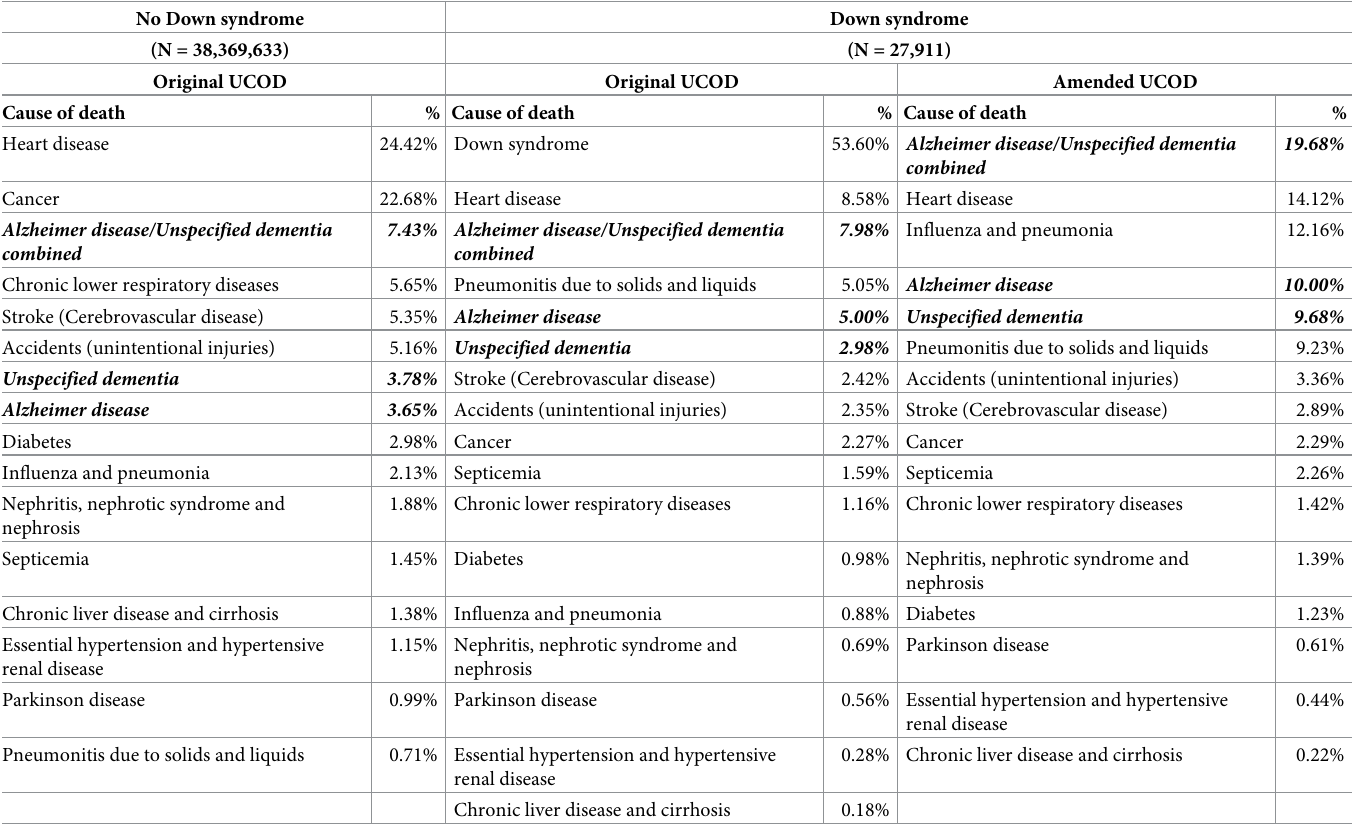
Table 2. Leading causes of death for adults with/without Down syndrome,